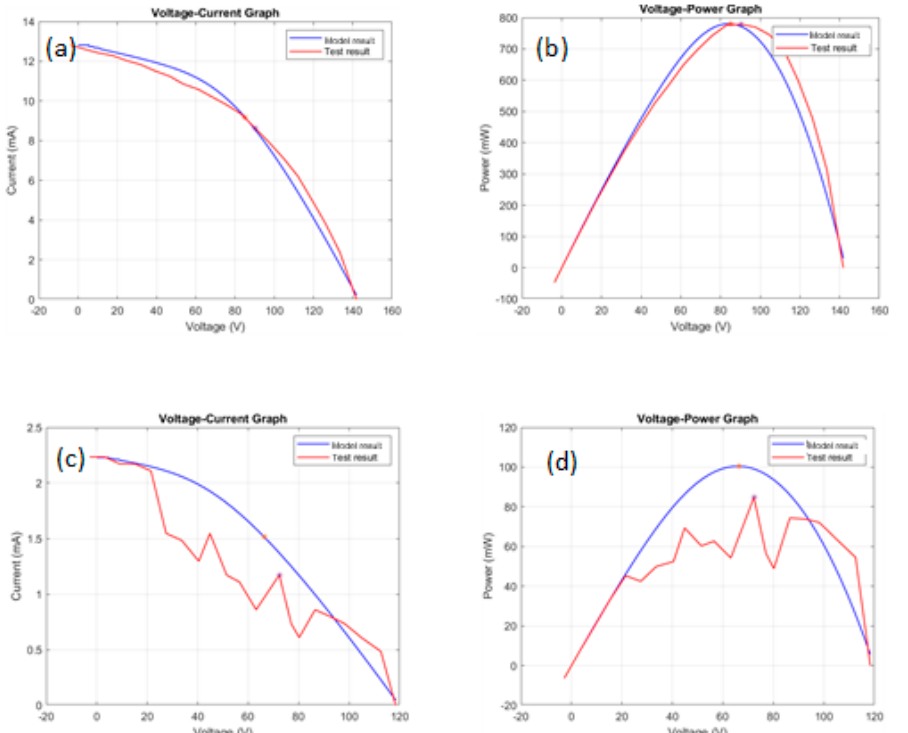
Figure 7. ( a ) I-V curve and ( b ) P-V curve comparisons of 2928 cm 2 module tested on 3 August 2018; ( c ) I-V curve and ( d ) P-V curve comparisons of 2928 cm 2 module tested on 29 October 2018. The maximum power point in each I-V/P-V waveform is highlighted as red or purple point, respectively.